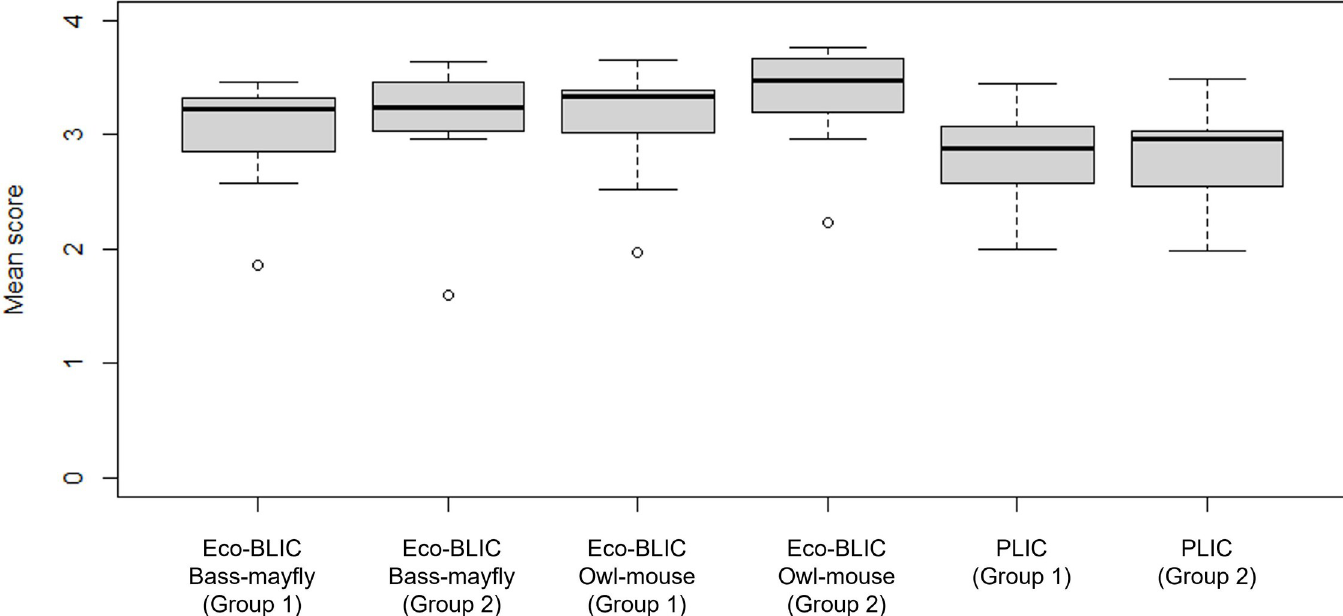
Fig 2. Boxplots representing mean scores and standard errors of individual evaluation questions for Group 1 and Group 2 across the Eco-BLIC and PLIC scenarios. Each box represents the interquartile range (IQR). Lines within each box represent the median. Circles represent outliers of mean scores for each question.